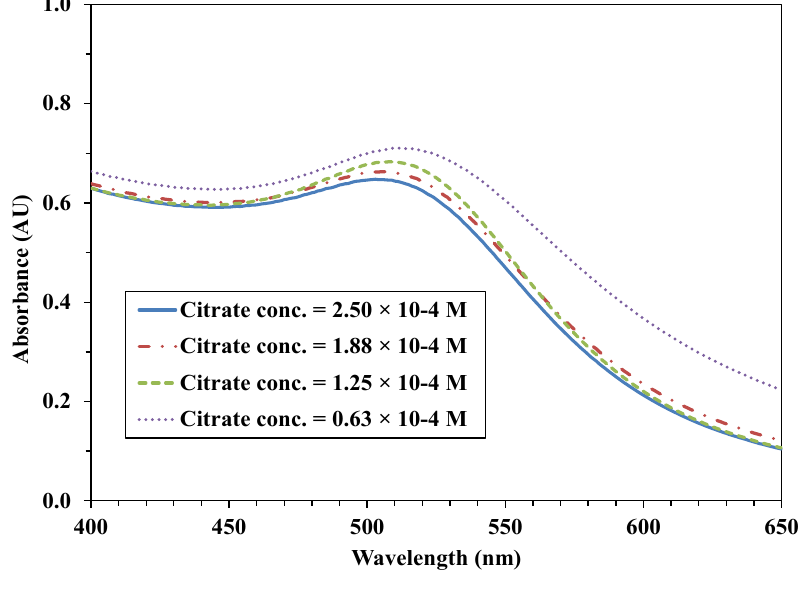
Figure 2. Absorption spectra of Au sols synthesized with different TC